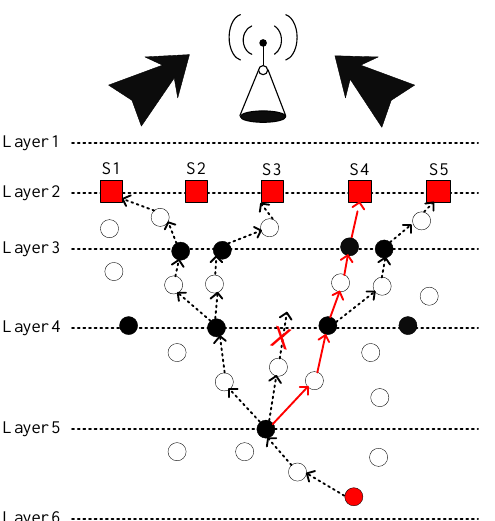
Figure 4. System model of BFS-SPF-Three.